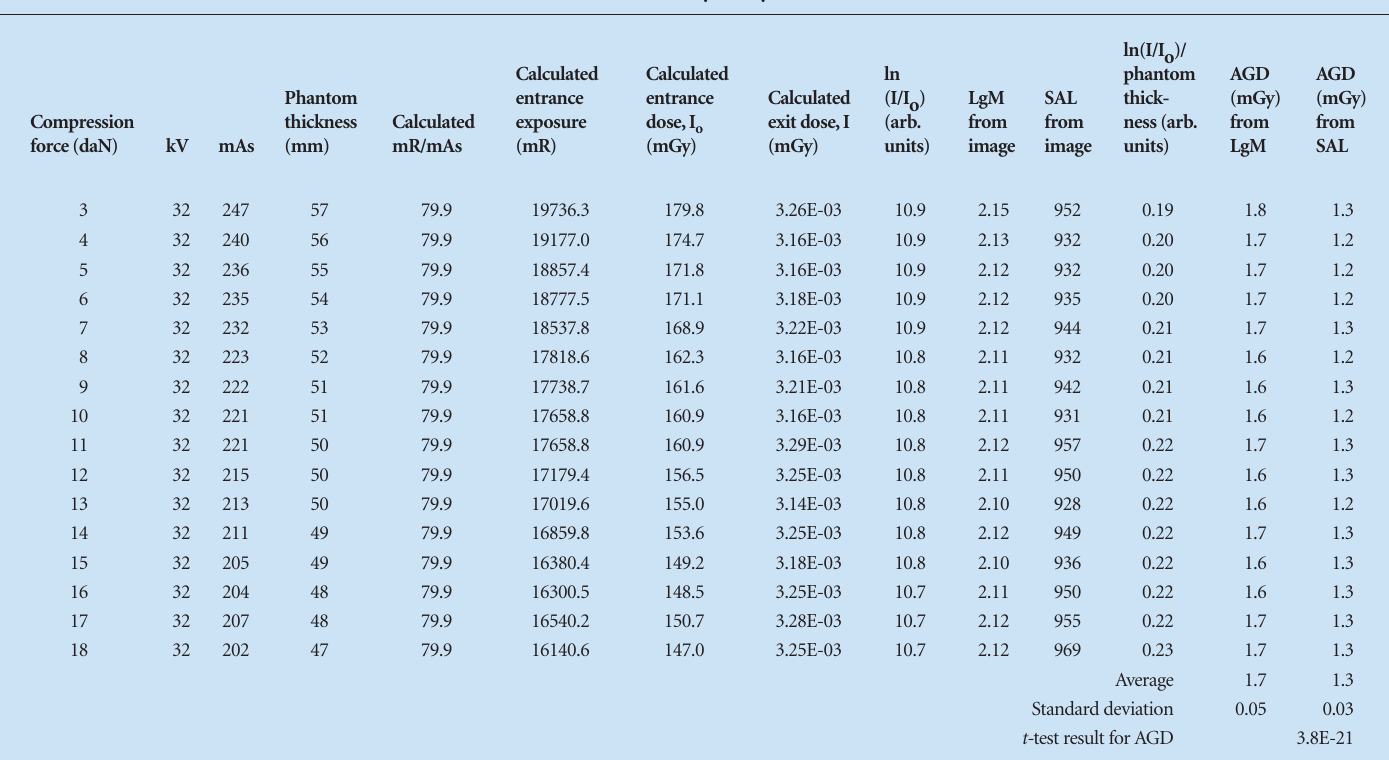
Table V. Dosimetry analysis